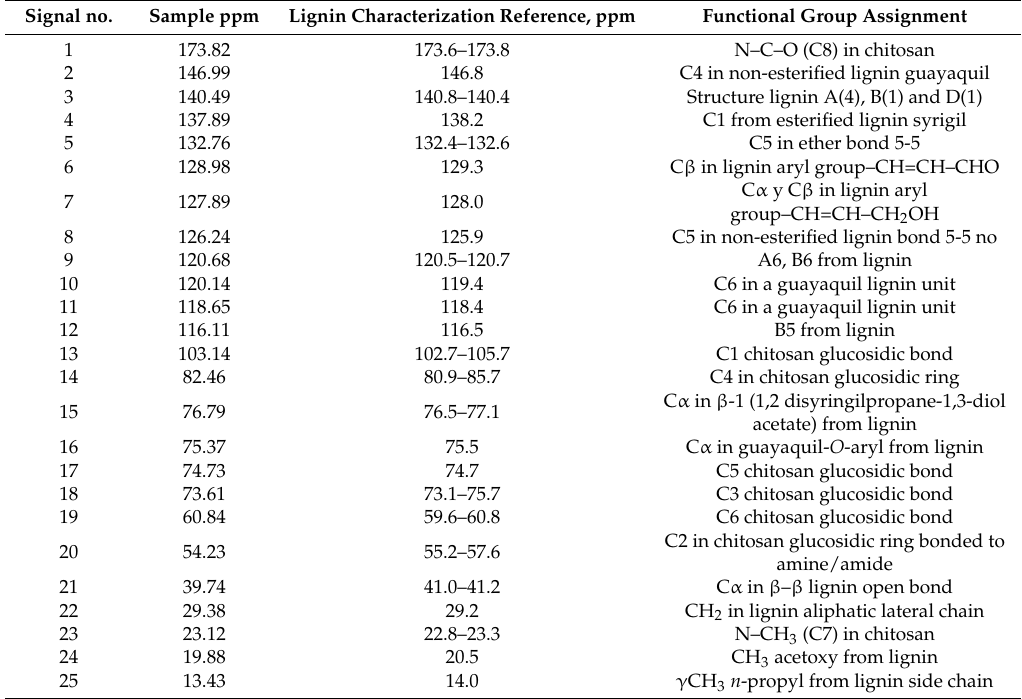
Table 3. 13 C NMR assignments from the spectra and reported data for